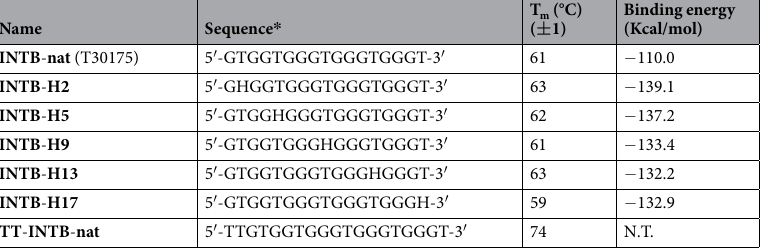
Table 1. Name, sequence, melting temperature and binding energy to HIV-1 IN of the ODNs investigated.